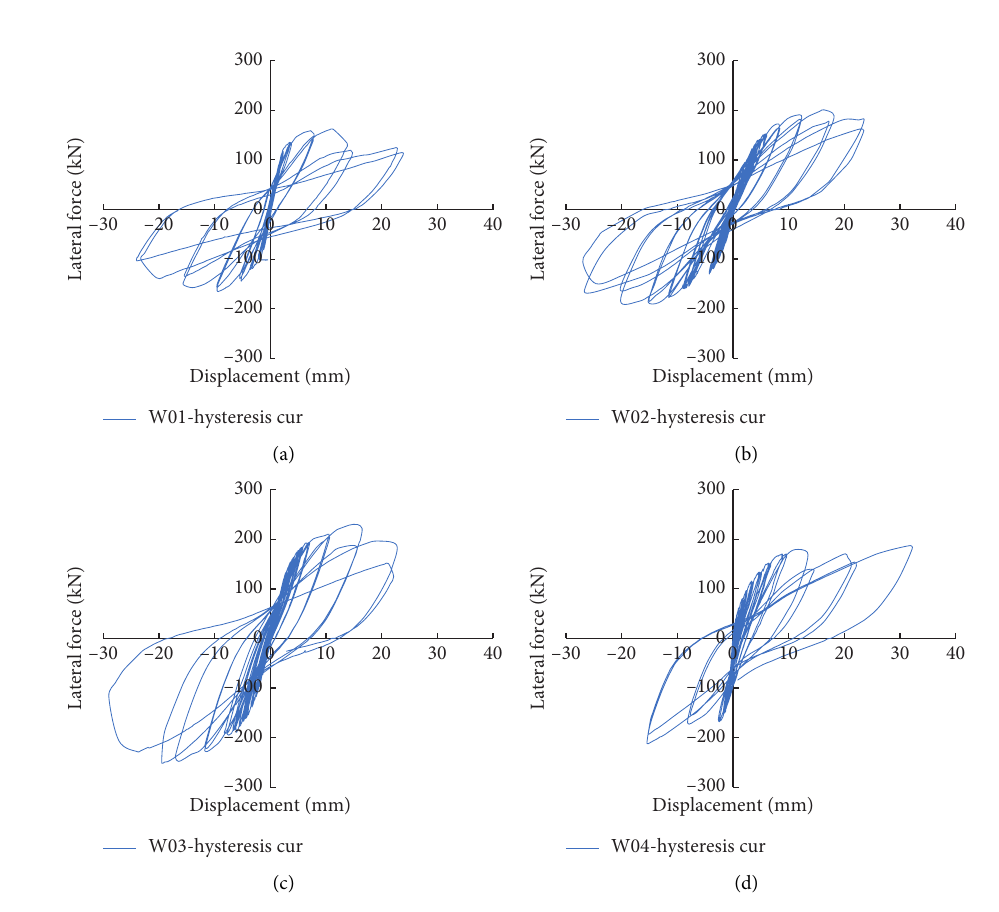
Figure 5: Hysteresis curve of the test piece. (a) W01. (b) W02. (c) W03. (d)